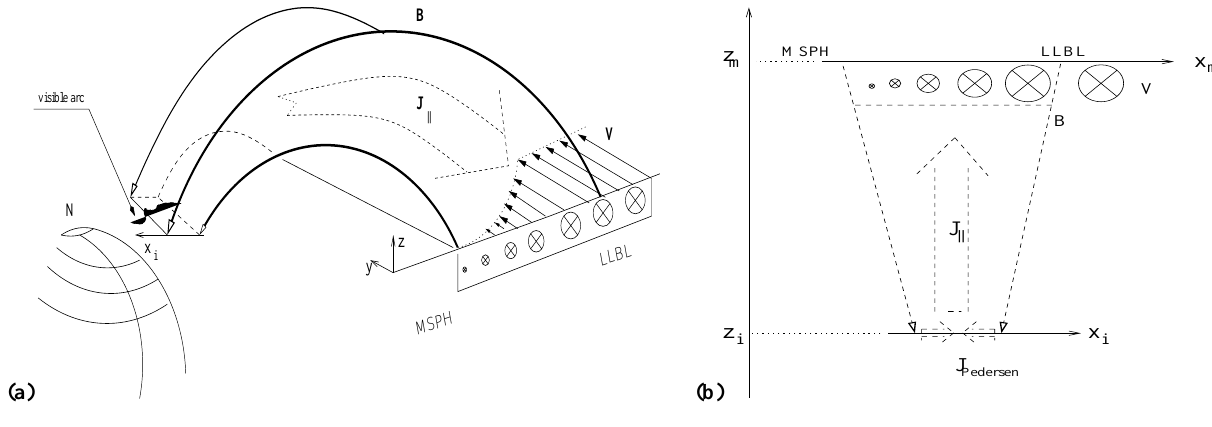
Fig. 1. Diagram illustrating the coupling between the magnetospheric sheared flow and the ionosphere. (a) A schematic 3-D view of the dusk flank; (b) A simpler, conical geometry has been adopted to describe a flux tube extended from lower/ionospheric altitudes ( z i ) to upper/magnetospheric level ( z m ). The upper boundary of the flux tube coincides with a magnetospheric sector that includes the sheared flow layer at the interface between the LLBL and Earthward region; the latter is labelled MSPH. The shear flow layer is described by a TD and plays the role of an auroral generator, as explained in the text. The velocity profile is illustrated by circles whose radius is proportional to the local value of the bulk velocity; the velocity is oriented anti-sunward, along the y-axis, into the page plane; the magnetic field lines and the parallel and horizontal currents are also